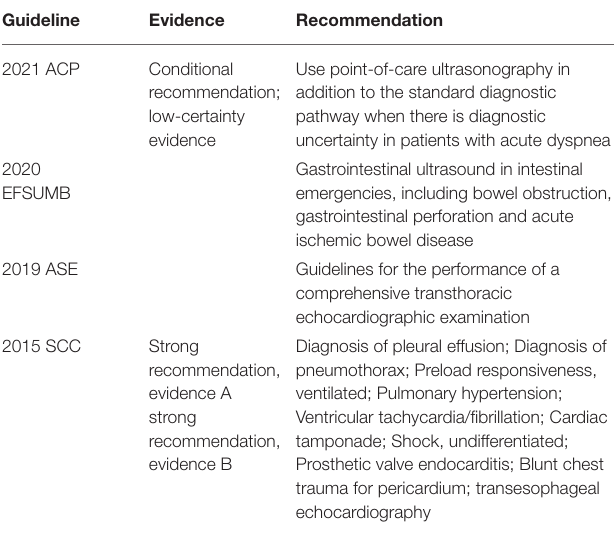
TABLE 2 | Main recommendation in society guidelines for